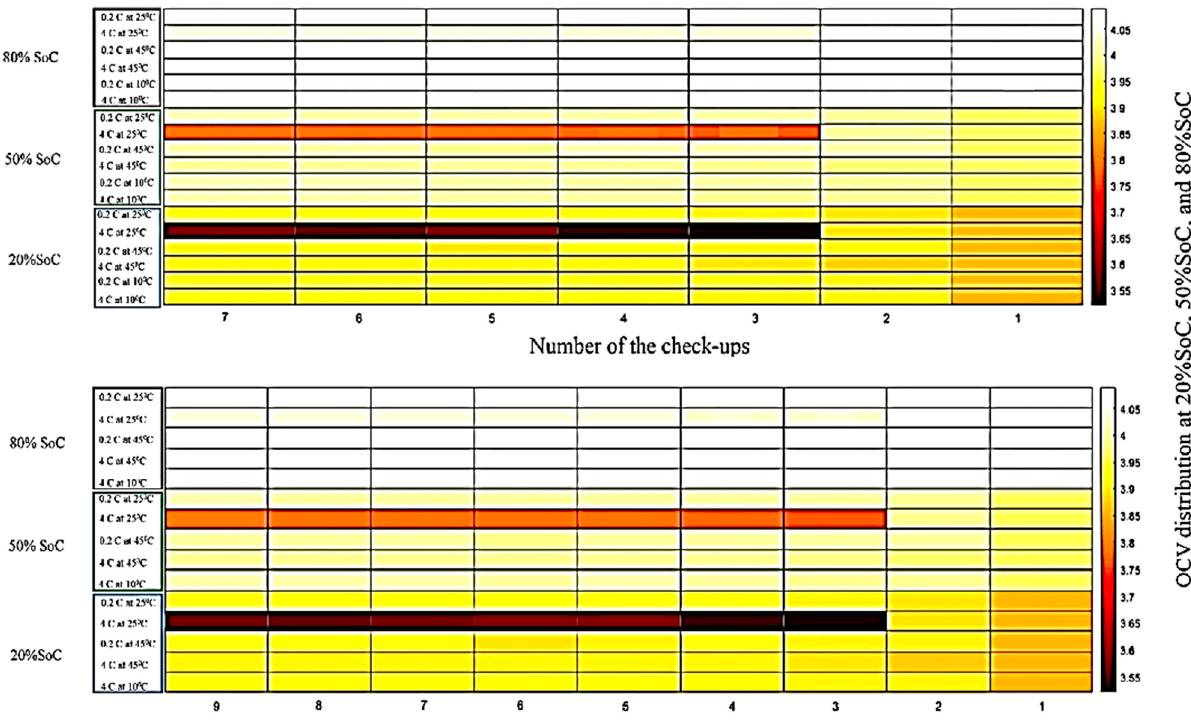
Figure 18. Behavior of the OCV at different SoC percentages under high and low discharge test conditions during the lifetime of the battery.